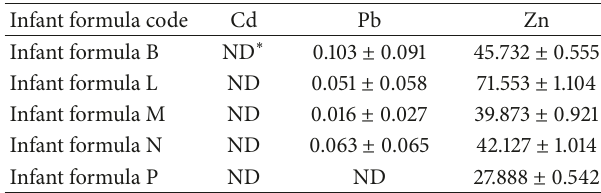
Table 1: Concentrations of metals (mg/Kg) in infant formula (mean ±